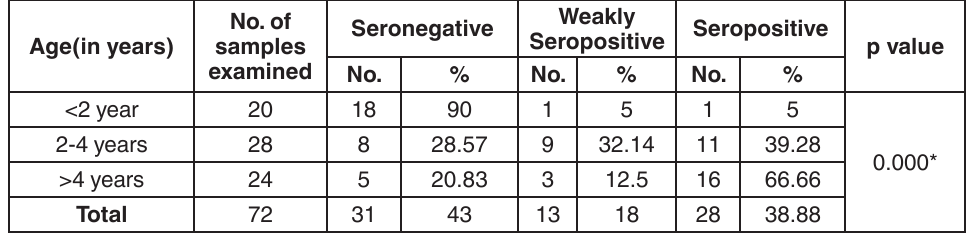
total *Highly significant (p<0.01) table 3. seroprevalence of T. gondii in goats related to grazing Grazing behaviour Regular grazing animals